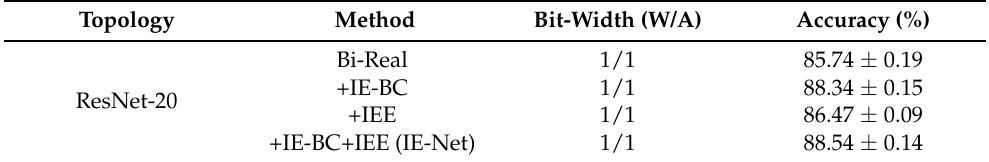
Table 3. Ablation performance on the CIFAR-10 dataset. We run each model three times and report the mean ± std accuracy on the test